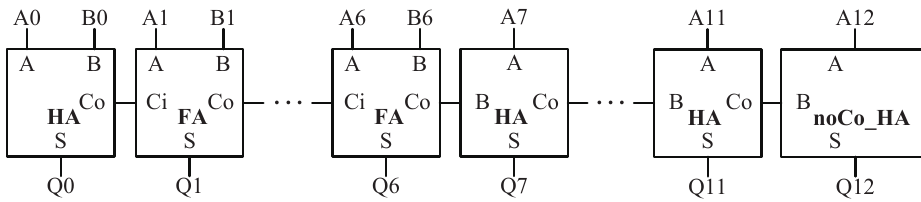
Figure 10. Block diagram of the full custom adder of 7 + 13 bits.